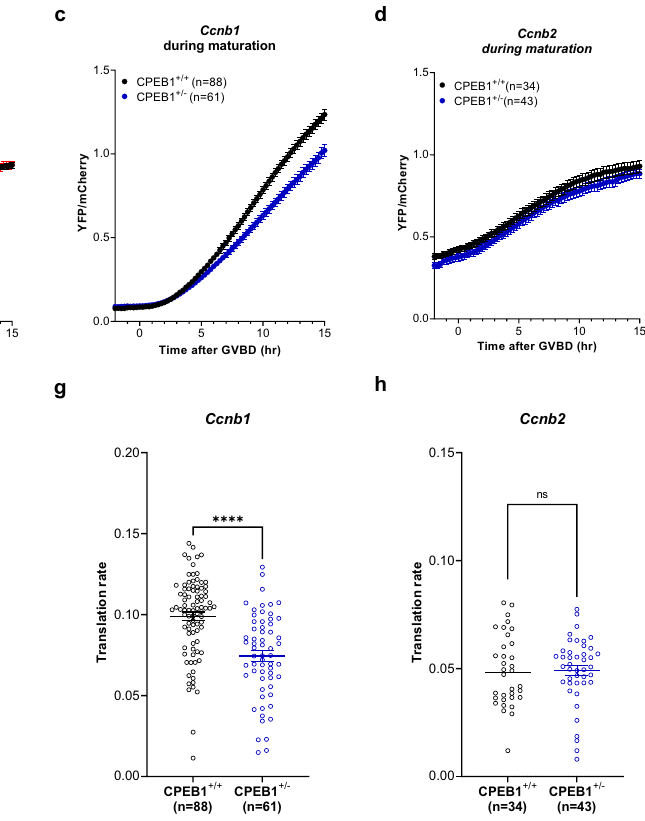
Fig.8|TheeffectofdecreasedCPEB1levelonCcnb1translationduringoocyte maturation. GV oocytes from young and old mice ( a , b , e , f ), or GV oocytes from Cpeb1 +/+ ;Zp3Cre mice (CPEB1 +/+ oocytes) and Cpeb1 fl /+ ;Zp3Cre (CPEB1 +/ − oocytes) ( c , d , g , h )wereinjectedwith12.5ng/ µ lpolyadenylatedmCherryand12.5ng/ µ l YFP- Ccnb1 3 ’ -UTR ( a , c , e , g ) or YFP-Ccnb2 3 ’ -UTR ( b , d , f , h ). After pre-incubation overnight, oocytes were released in the cilostamide-free medium for maturation.